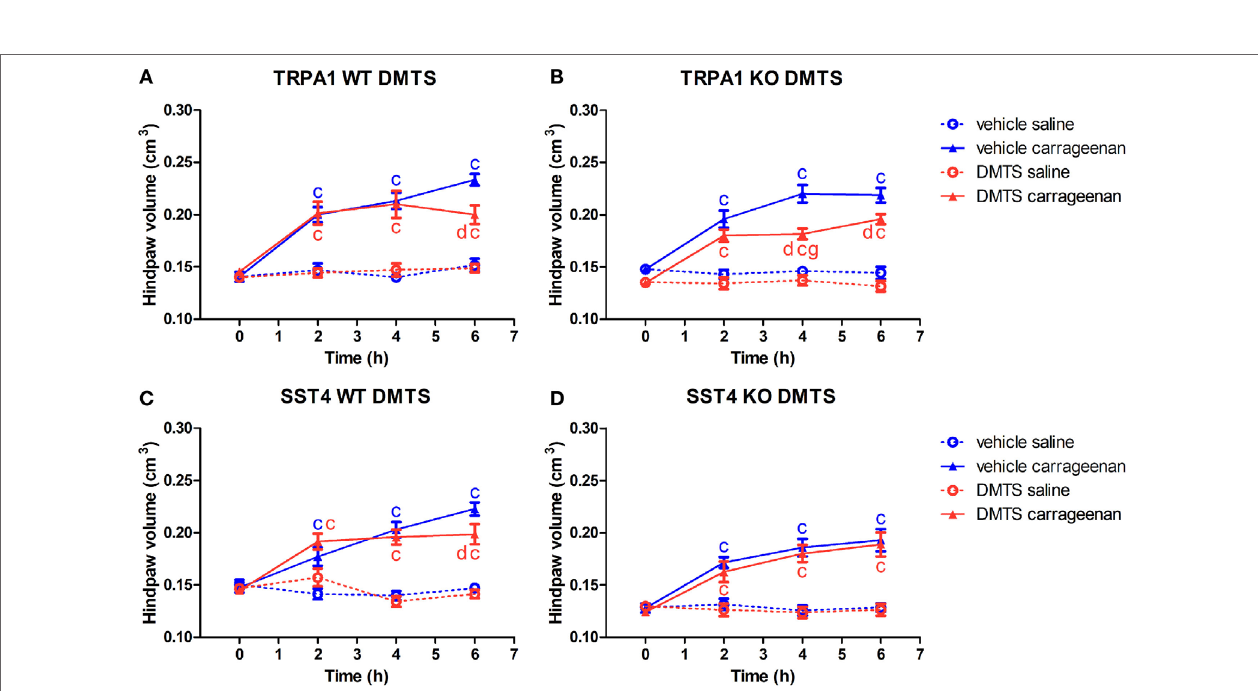
FigUre 4 | Alleviating effect of dimethyl trisulfide (DMTS, 250 µmol/kg, i.p.) on edema formation in carrageenan-induced hind paw inflammation is independent of the transient receptor potential ankyrin 1 (TRPA1) ion channel, but is mediated by somatostatin (SOM) sst4 receptors. Effect of DMTS or vehicle treatment on hind paw edema detected by plethysmometry in saline or carrageenan-treated (3% in 20 µL saline) feet of (a) TRPA1 WT, (B) TRPA1 KO, (c) sst4 receptor WT, and (D) sst4 receptor KO mice. Data are shown as mean ± SEM. n = 6–8. c p < 0.05 vs. saline-injected paws. d p < 0.05 vs. vehicle of DMTS. g p < 0.05 vs. TRPA1 WT animals. Two-way repeated-measure ANOVA followed by Bonferroni’s multiple comparison test.